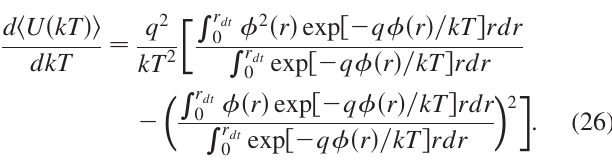
FIG. 4. Heat capacity plotted against scaled temperature for an Ar 18 þ ion cloud. The conditions are: initial axial density, 5 (cid:5) 10 6 cm (cid:1) 3 ; current, 50 mA; beam energy, 50 keV; trap depth, 100 V; magnetic field, 4